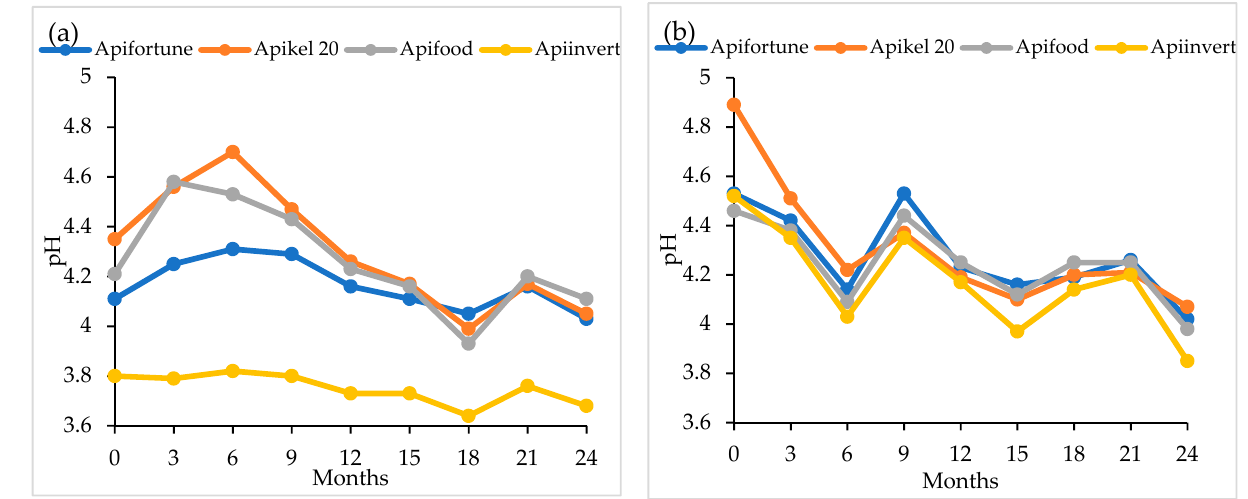
Figure 17. Changes of pH of syrups during storage at ca. 20 °C ( a ) from 2012 and ( b ) from 2013.